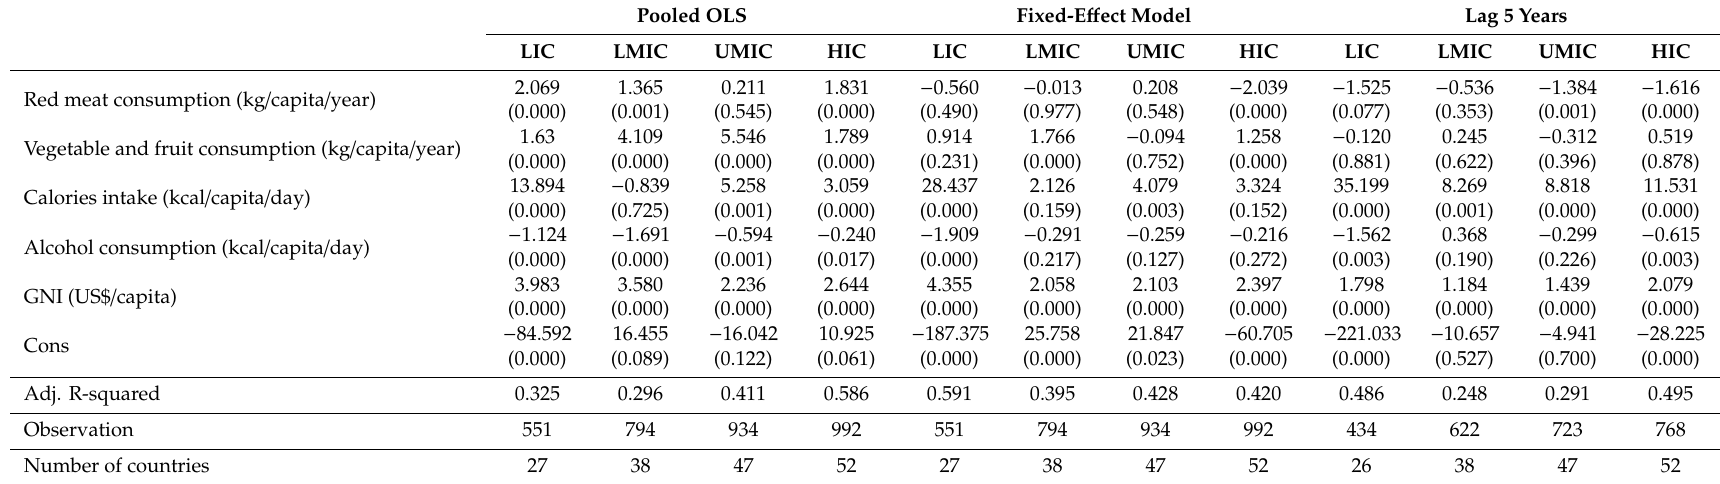
Table 3. Adjusted estimates from regression models using pooled OLS, fixed-e ff ects, and a 5-year lag for red meat